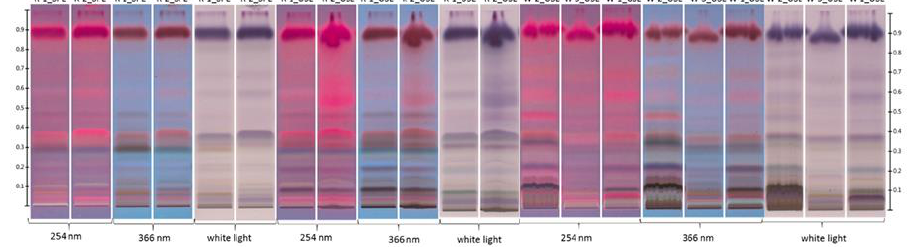
Figure 3. HPTLC fingerprint of rape and willow honeys after derivatisation (UAE—ultrasound assisted extraction, SPE—solid phase extraction visualised under white light, 254 nm and 366 nm; R— rape honeys; W—willow honeys.